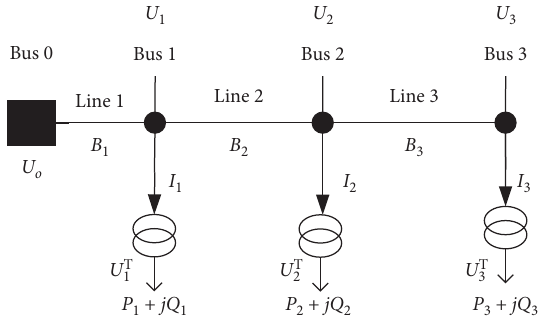
Figure 3: Computational